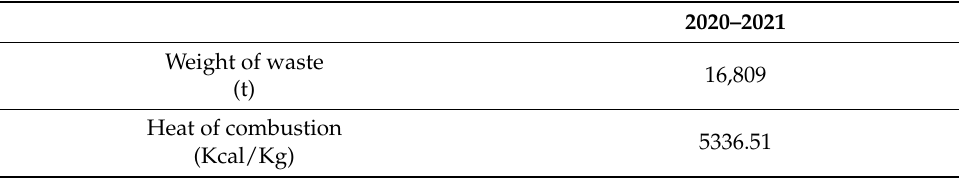
Table 2. Characterization of the extracted